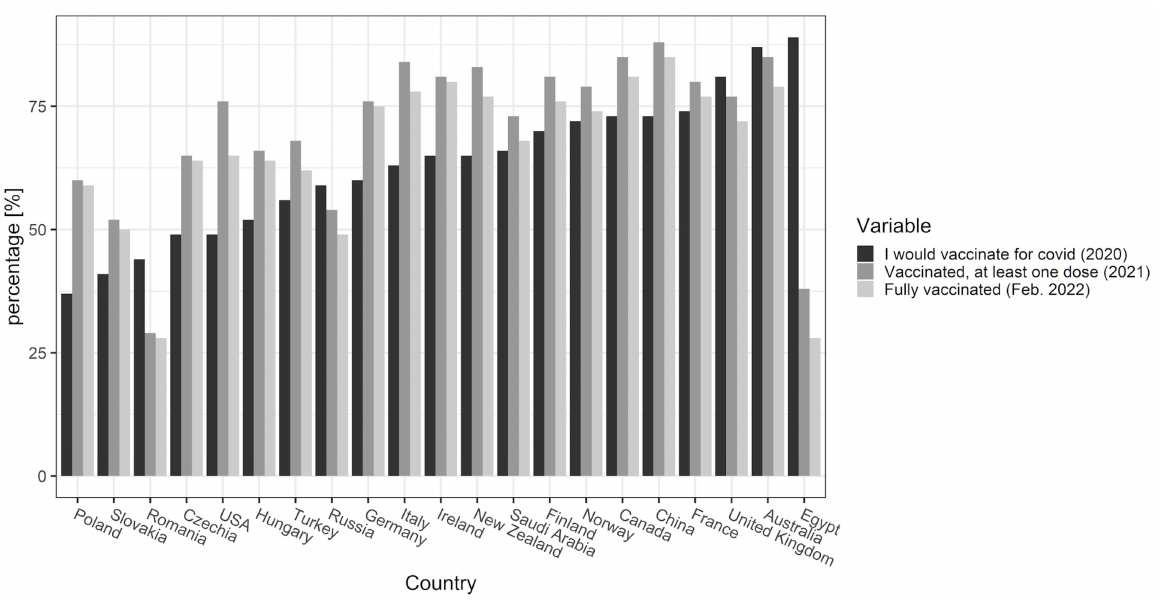
Figure 1. An international overview of the willingness to vaccinate against COVID-10 (in 2020) and the actual vaccination rate in 2021 and